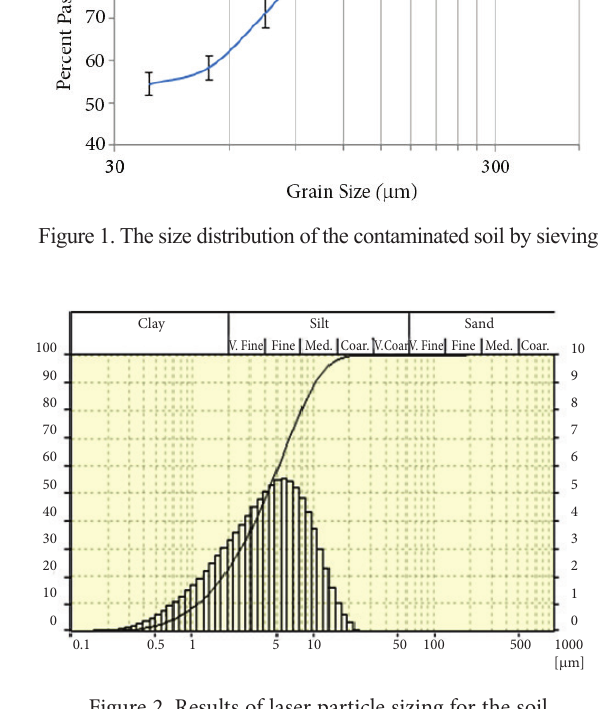
Figure 2. Results of laser particle sizing for the soil